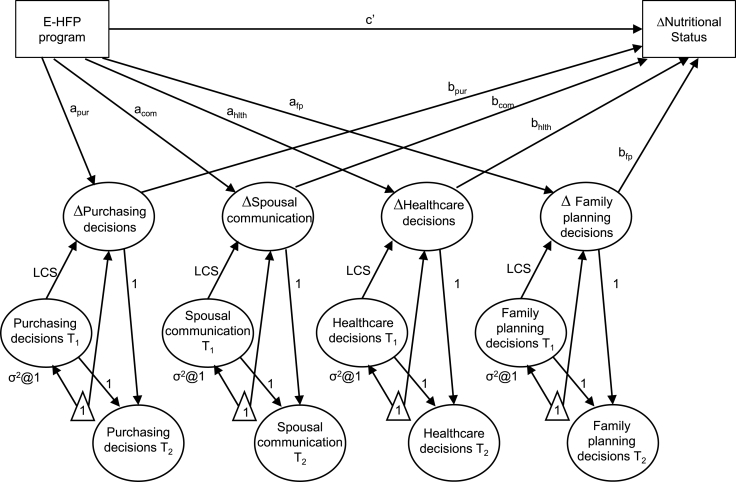
Structural equation model depicting change in women's empowerment as a mediating pathway between the program and change in nutritional status.Note: Each domain of empowerment is a latent variable measured by multiple indicators, which, along with error terms, are not shown for simplicity. Observed variables are depicted by squares, latent variables by circles, and constants by triangles. Consistent with the latent change score approach, the variance of each T1 latent variable, paths from T1 to T2, and paths from Δlatent variable to T2 are held constant at one. E-HFP = Enhanced Homestead Food Production. LCS = latent change score.